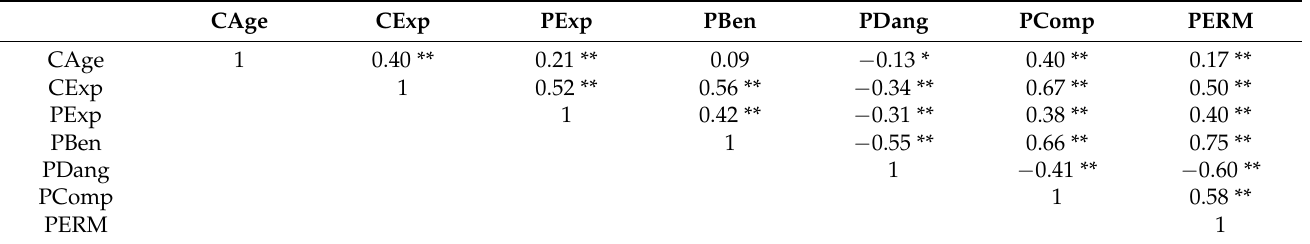
Table 4. Pearson coefficients of correlation between child age, parent and child experiences, parental perceptions, and permission to